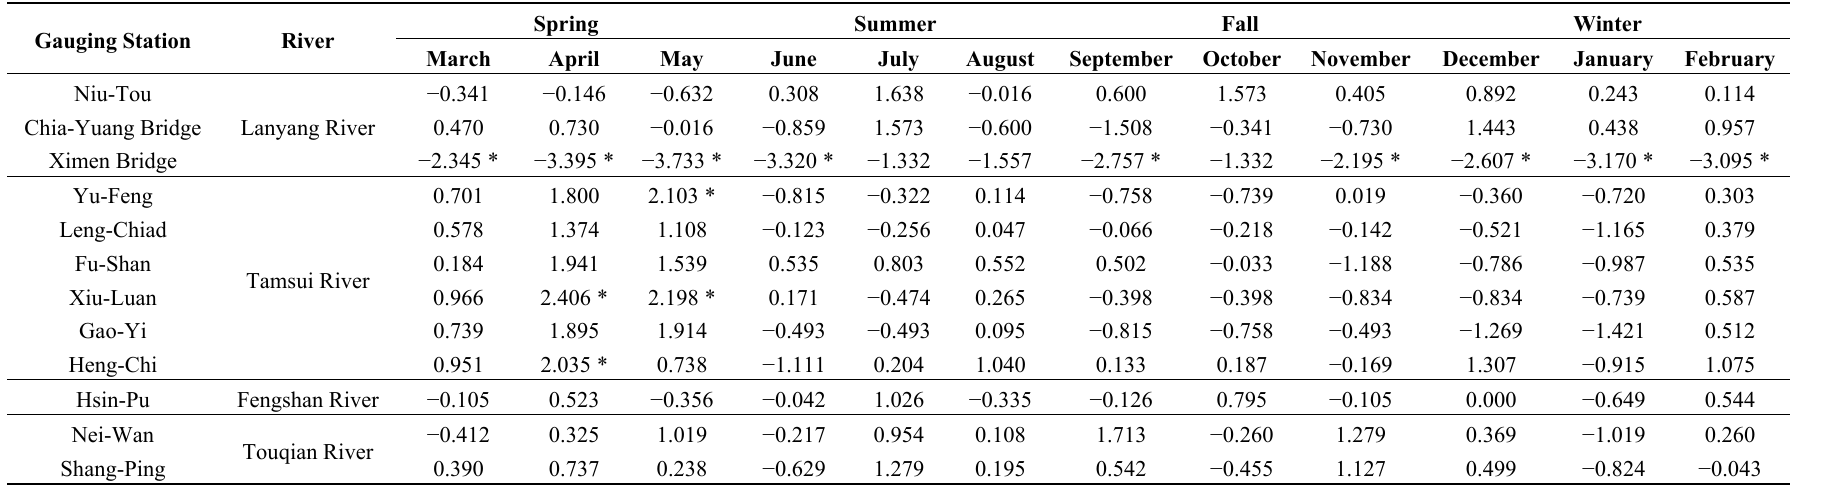
Table 4. Results of the trend distribution for four seasons.